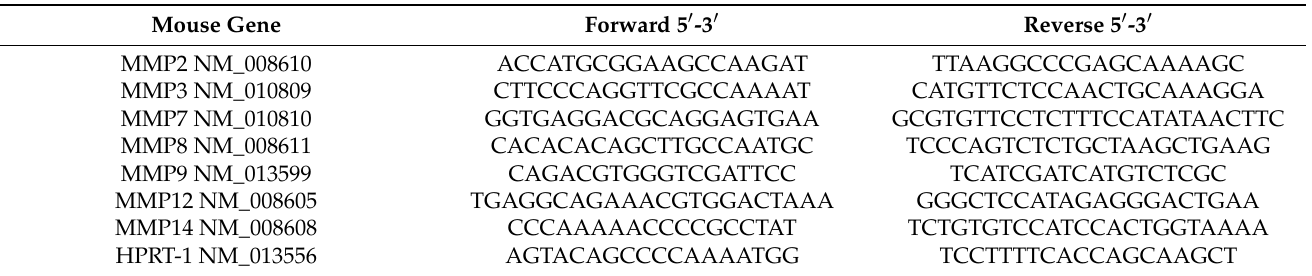
Table 1. Sequences of the primers used in this